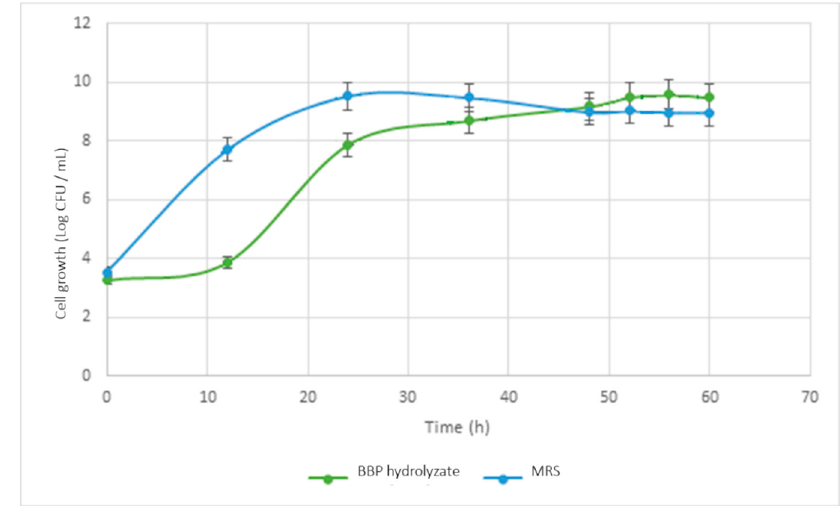
Figure 2. Cell growth of L. plantarum ATCC 8014 in the medium based on bovine blood plasma with hydrolyzed proteins at bench scale and its comparison with a laboratory level culture in the MRS reference medium.